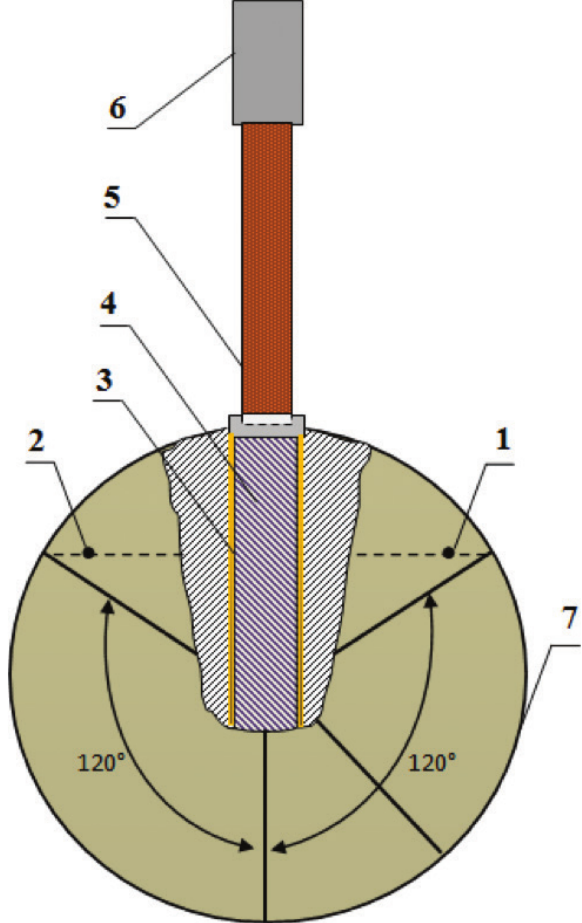
Figure 2. Layout of the spherical element: 1, 2 – thermocouples; 3 – thermal paste; 4 – electrical heater; 5 – fiber-reinforced lam - inate rod; 6 – support; 7 – copper